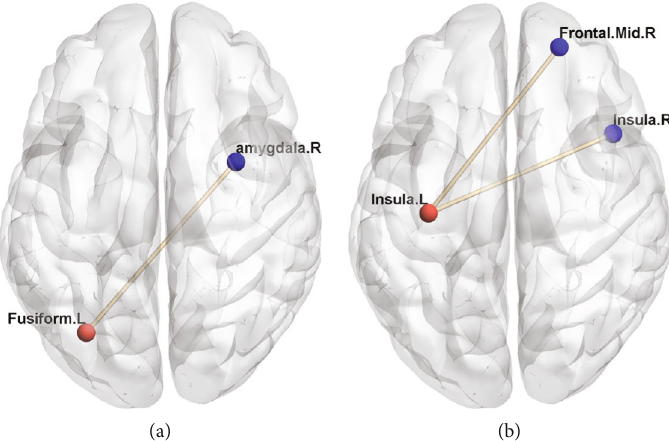
Figure 2: RS-FC di ff erences between CPP and PPP. The fi gure shows girls with CPP having lower connectivity from the left insula to the right insula and the right middle frontal gyrus and from left fusiform to the right amygdala. All results shown are signi fi cant at P < 0 : 005 (AlphaSim). (a) The left fusiform as a seed. (b) The left insula as a seed.